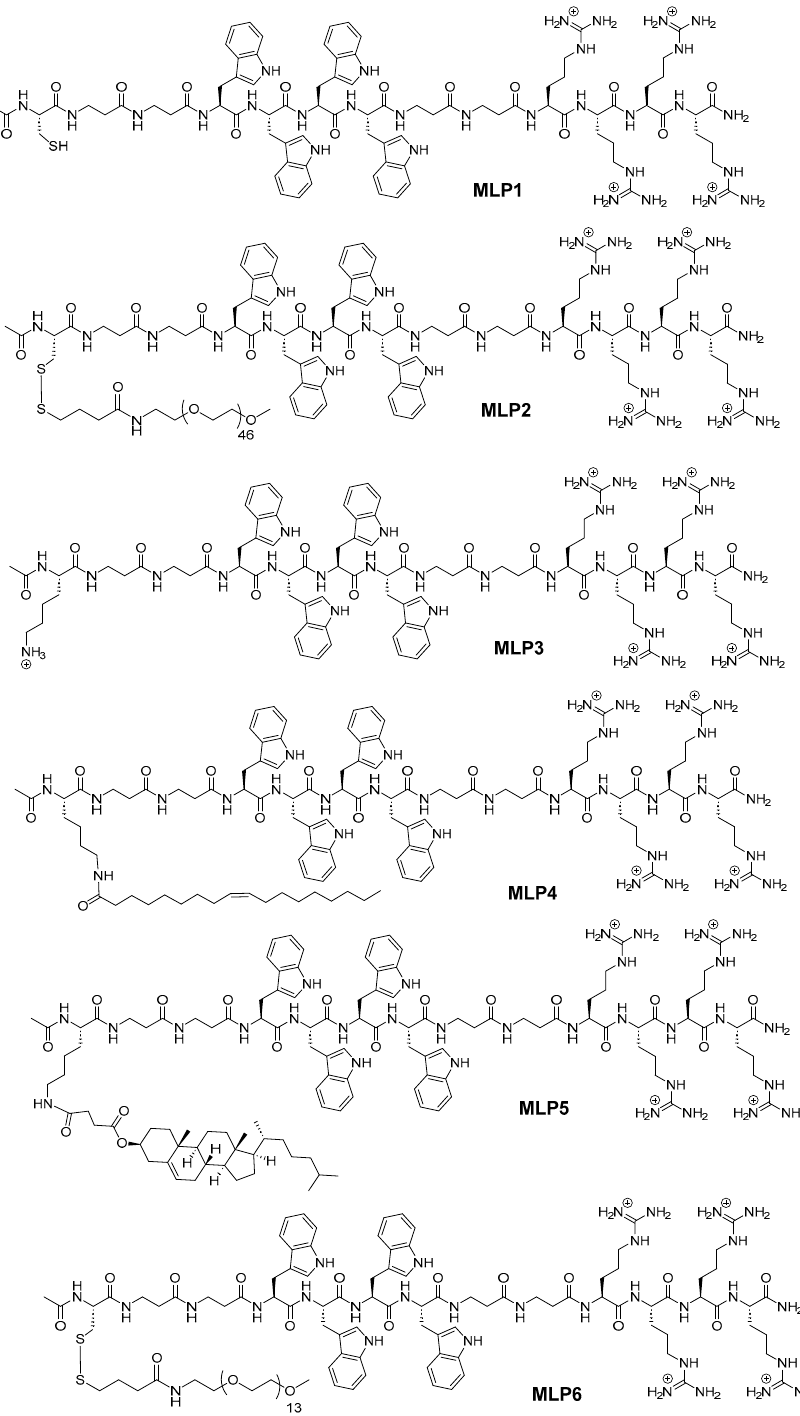
Figure 1. Chemical structures of peptides used in this study.